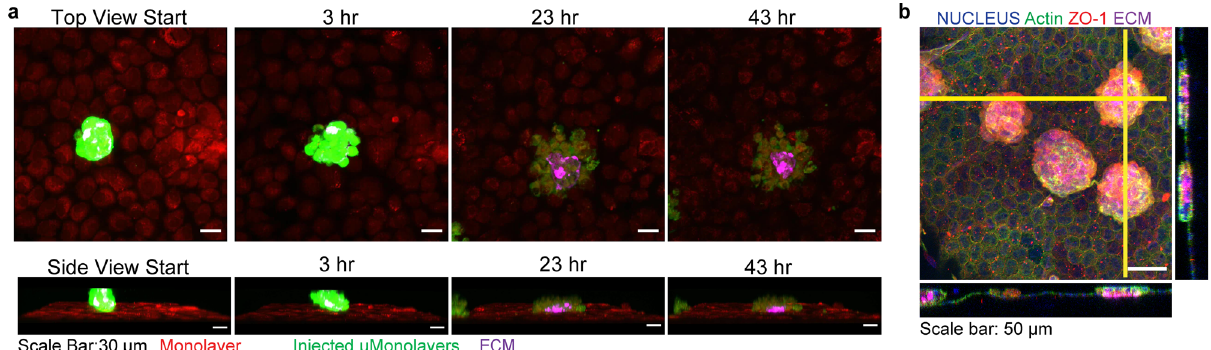
Fig. 5 Shrink-wrapped μ Monolayers begin to integrate into low-density CE monolayers and ex vivo corneas within 3 hours. a Time-lapse images from live confocal imaging of the integration of shrink-wrapped bovine μ Monolayers (Cell Tracker green) into an engineered bovine CE monolayer (Cell Tracker Orange). At 3 hours, the μ Monolayers have attached and begun to integrate and by 43 hours the cells are almost completely integrated into the monolayer. b Confocal images show that the shrink-wrapped rabbit μ Monolayers had begun to integrate into the ex vivo rabbit CE and the ECM scaffold is observed to be between μ Monolayers and the existing rabbit CE. The yellow vertical and horizontal lines indicate the places at which the orthogonal views were